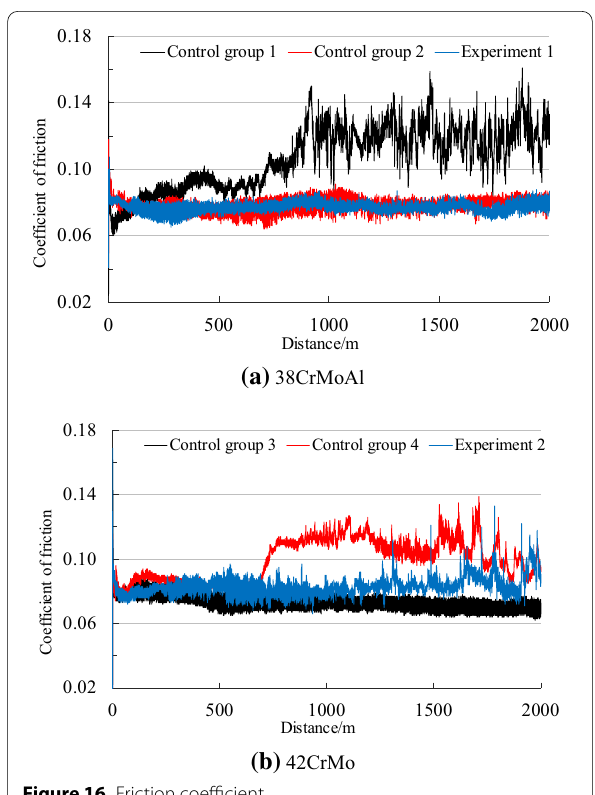
Figure 16 Friction coefficient